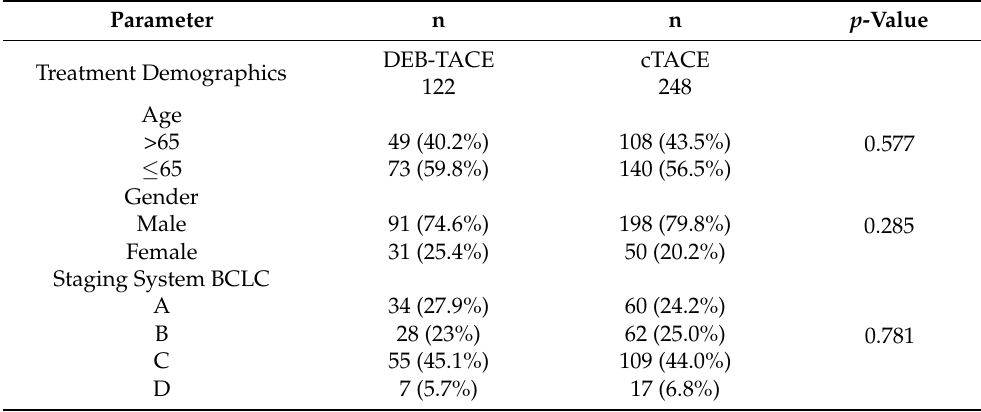
Table 1. Baseline patient characteristics.